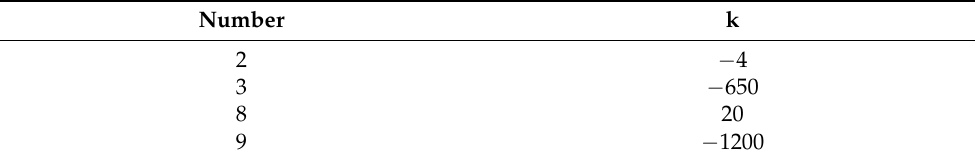
Table 3. Specific parameters of